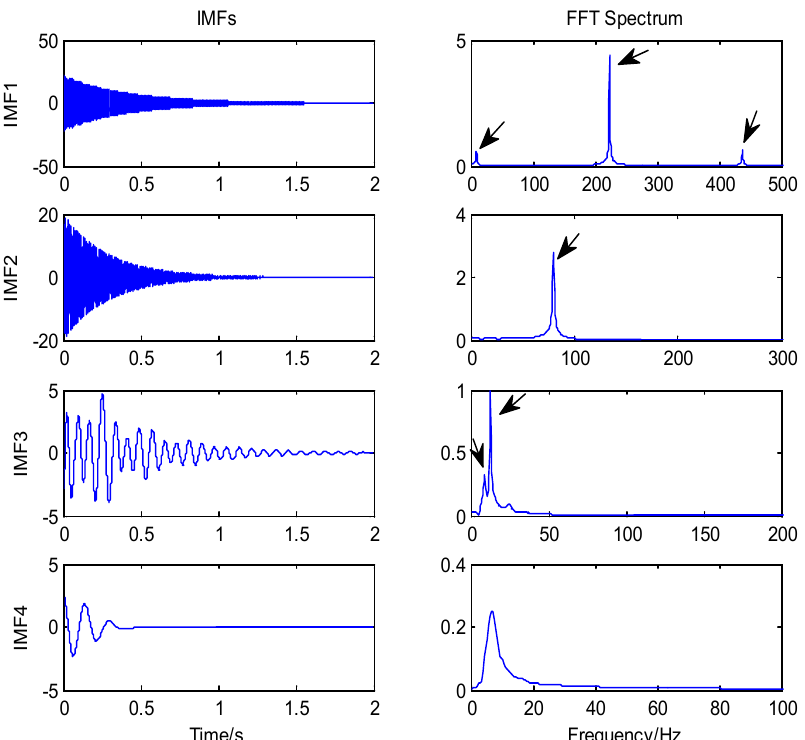
Figure 3. Partial IMFs obtained using EMD and the corresponding FFT frequency−spectrum.